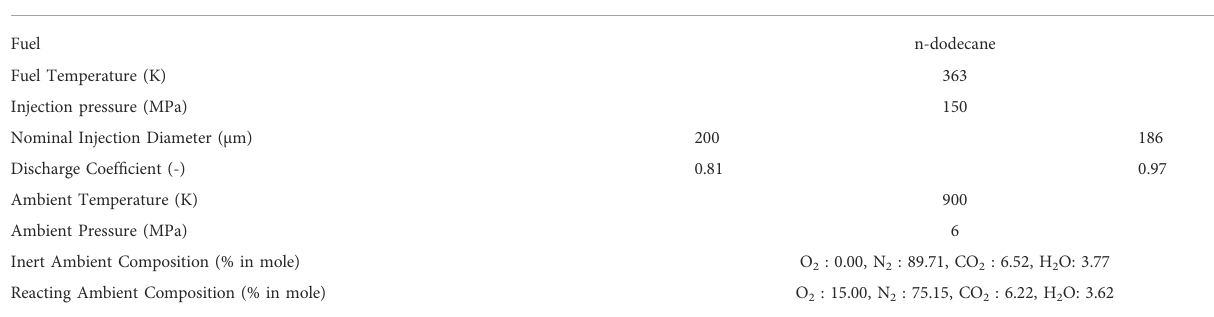
TABLE 2 Speci fi cations for ECN Spray C and Spray D (ECN, 2022).